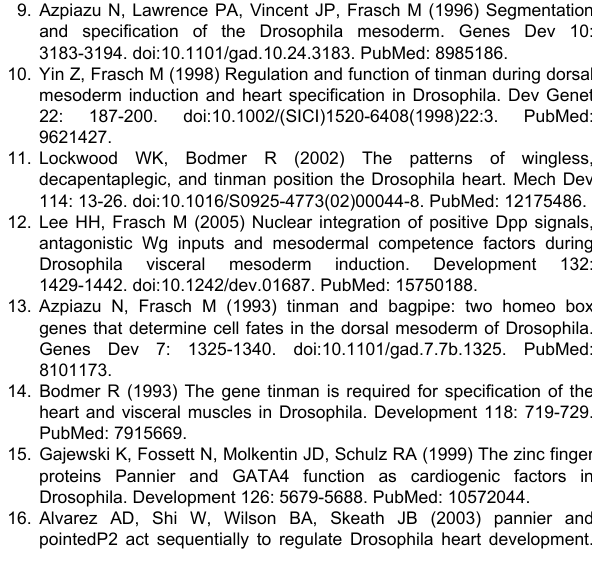
Figure S2. Heart phenotypes in embryos mutant for the the Iro-C show a downregulation of Doc in the cardiac region (arrows). (D-F) Almost 80% of the iro DFM3 embryos are characterized by additional Tin-expressing cells at stage 12 (arrowhead). The strong downregulation of FasIII (asterisk)